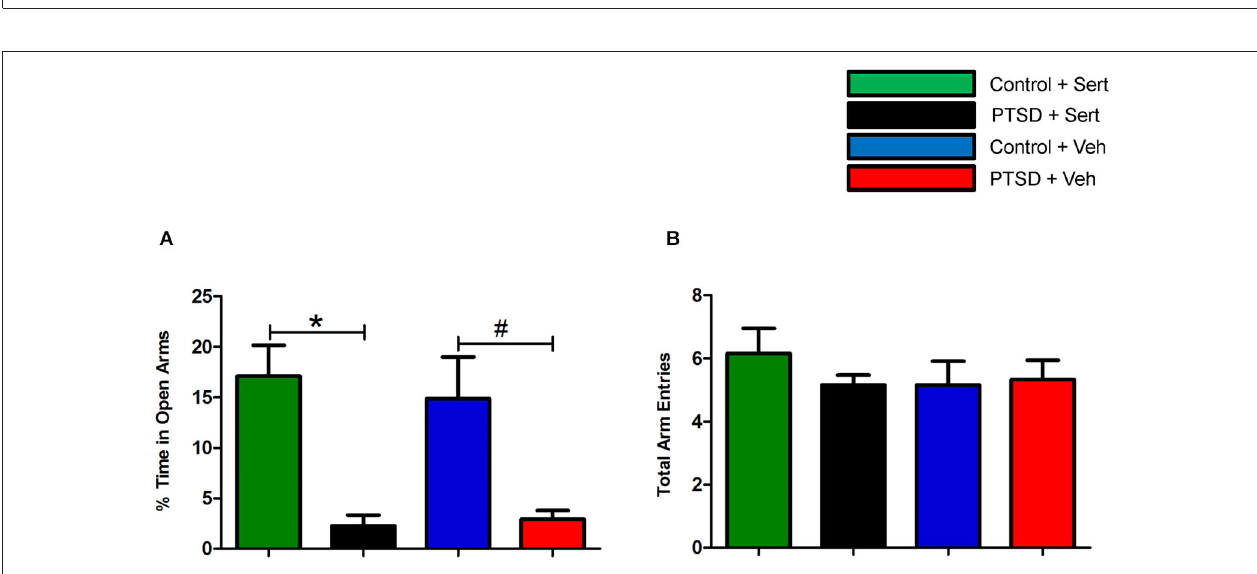
FIGURE 1 | Elevated plus-maze performance: within group measurements . The PTSD group spent considerably less time in the open vs. closed arms compared to the control group and to baseline (A) . There